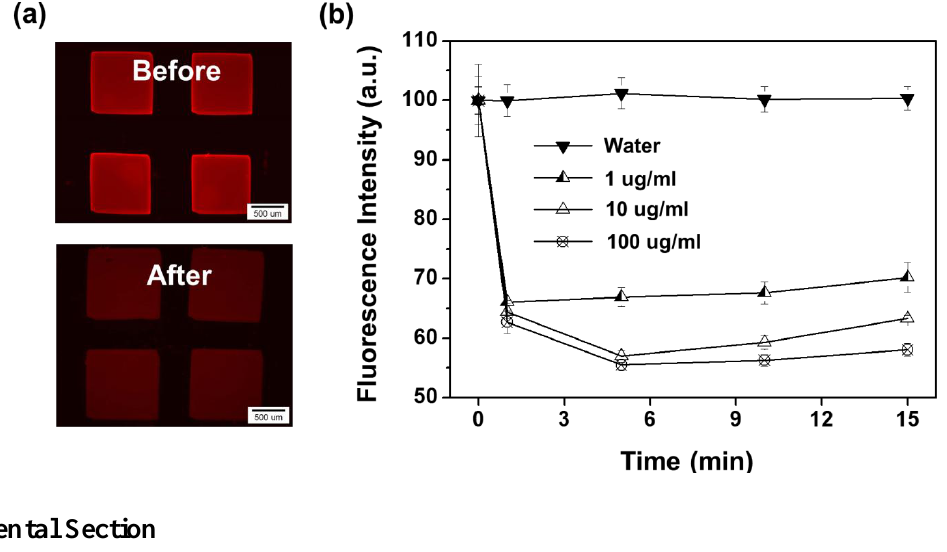
Figure 8. ( a ) Fluorescence micrographs of Fe the 100 µg/mL Pd 2+ and ( b ) variations of the fluorescence intensity as a function of contact time with different Pd 2+